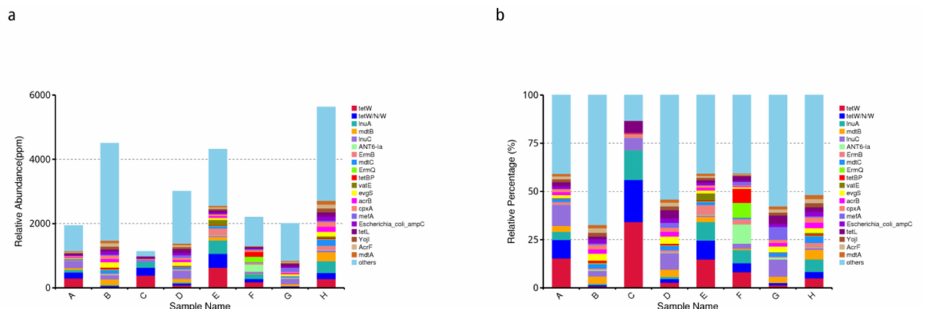
Figure 13. Histogram of the abundance of different AROs in each sample. ( a ) The relative abundance of all genes of ARO in each sample, in ppm, which is the result of enlarging the original relative abundance data by 106 times. ( b ) Indicates the relative abundance of the top 20 AROs among all AROs, and the others are the sums of the relative abundances of the top 20